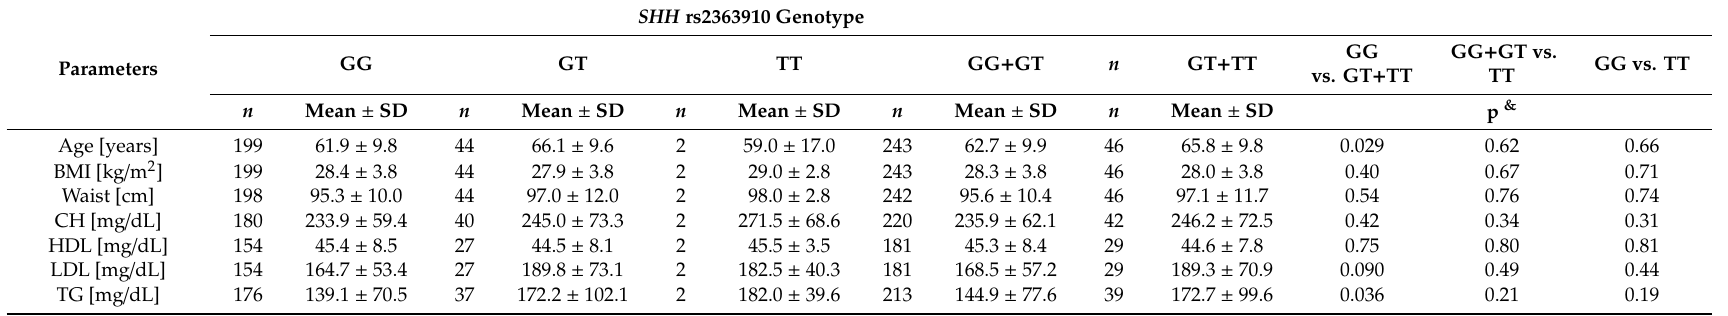
Table 8. Associations between the clinical parameters of patients with unstable angina and the SHH rs2363910